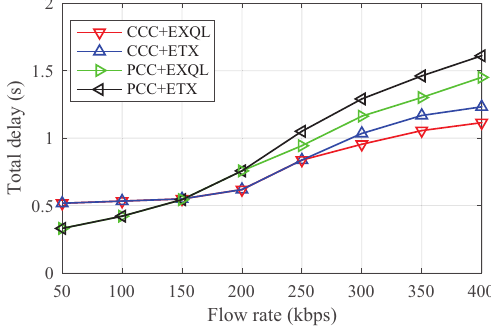
Figure 12. Delay versus flow rate in the grid network.